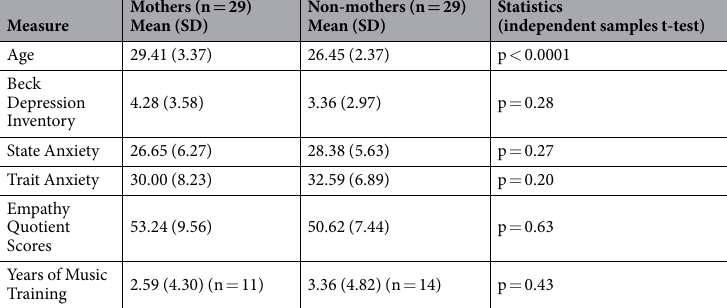
Table 1. Participant demographics by parental status.